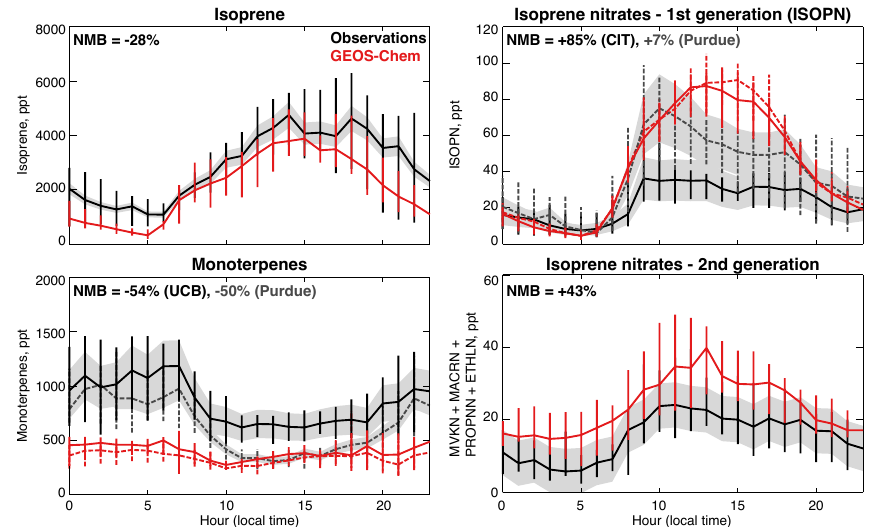
Figure 6. Observed (black, gray) and simulated (red) median diurnal cycles of isoprene, monoterpenes, first generation isoprene nitrates (ISOPN), and second generation isoprene nitrates (MVKN+MACRN+PROPNN+ETHLN) at Centreville during the 2013 SOAS campaign. Gray shading represents the measurement uncertainty, vertical bars show the interquartile range of the hourly data, and the normalized mean bias (NMB) of the simulation is given inset. The model has been sampled in the Centreville grid box only for hours with available data during 16 June–11 July for isoprene and monoterpenes from the UC Berkeley PTR-ToF-MS (solid black), 13 June–15 July for α -pinene + β -pinene from the Purdue 2D-GF-FID (dashed gray), 1 June–11 July for ISOPN from the Purdue CIMS (dashed gray), and 1 June–4 July for ISOPN and second generation isoprene nitrates from the CIT-ToF-CIMS (solid black). For ISOPN and monoterpenes, differences in data availability between the two measurements result in slightly different model values (solid/dashed red lines).